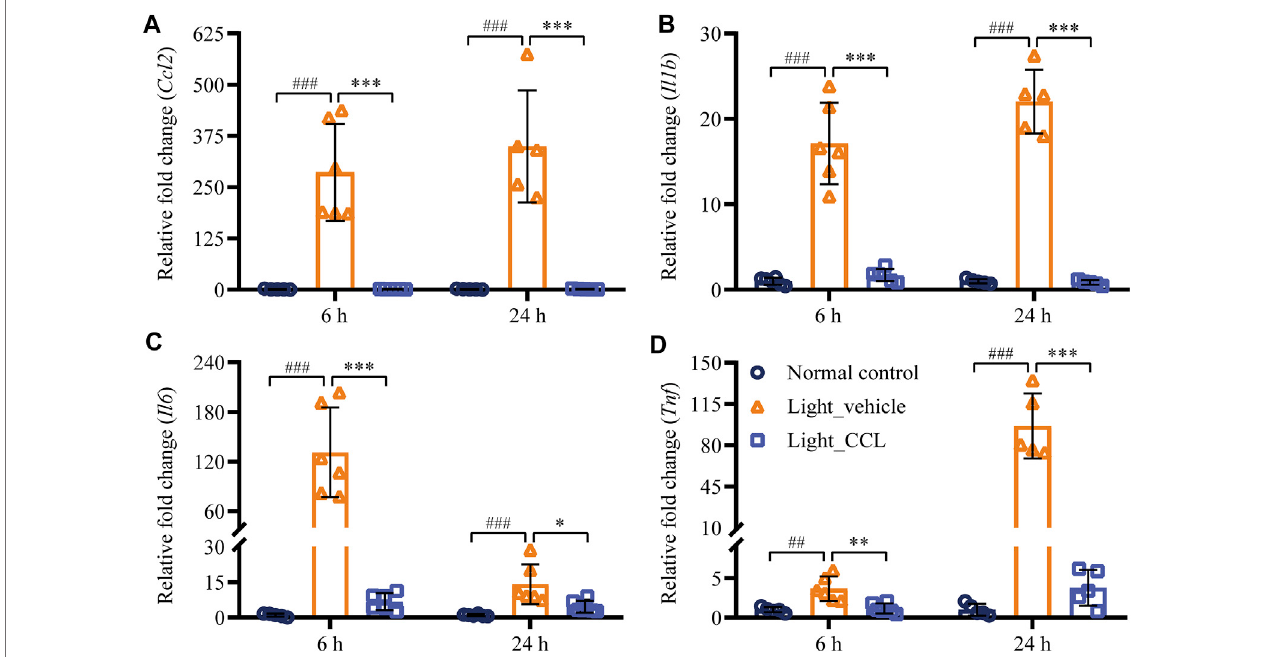
FIGURE 10 | CCL suppresses the expression of proin fl ammatory genes in the light-exposed retinas. Total RNA was isolated from the retinas collected from the indicated experimental groups 6and 24 h after lightexposure.Real-time qPCR analyses were performed toexaminethe expression of Ccl2 (A) , Il1b (B) , Il6 (C) ,and Tnf (D) inthe retina. Relative fold change wasnormalized against that from Normal control. The datawereexpressed asthe mean ±SD (n= 5-6per group). ## Compared to Normal control, p < 0.01; ### Compared toNormal control, p < 0.001;* compared toLight_vehicle, p < 0.05; **comparedtoLight_vehicle, p < 0.01; ***compared to Light_vehicle, p <